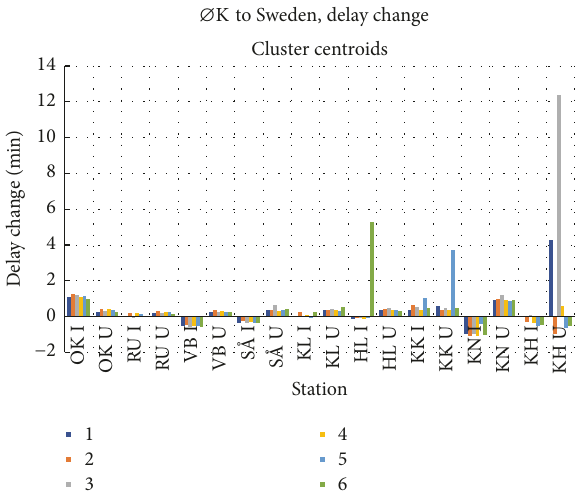
Figure 10: Cluster centroids for southbound ØK trains: delay